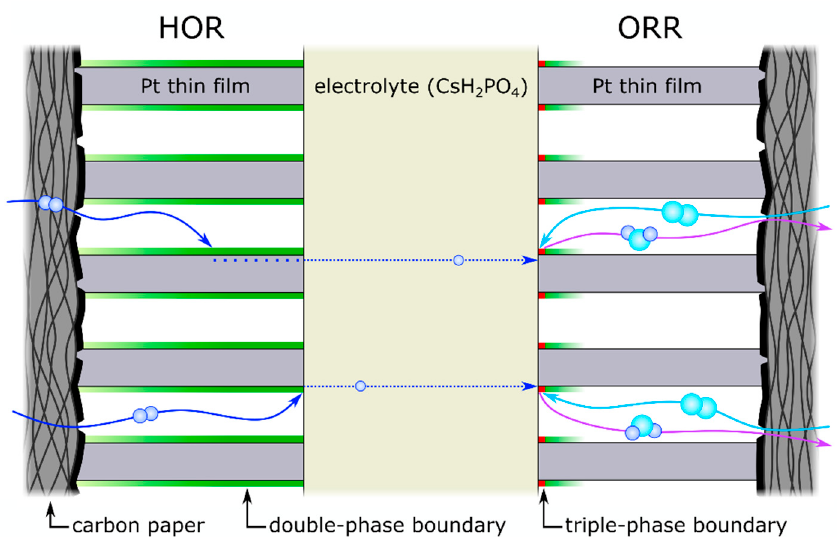
Figure 9. Cross-section through the membrane electrolyte assembly (MEA) with an illustration of the reaction pathways of the hydrogen oxidation reaction (HOR) on the left side and the oxygen reduction reaction (ORR) on the right side. The gases hydrogen (dark blue) and oxygen (light blue) as well as the reaction product, water, are marked. The green marked areas indicate the active double-phase boundary (for HOR—within 60 nm layer thickness with equal and above 60 nm gradual contribution; ORR—with a gradual contribution within 15 nm layer thickness) and the red dots the contribution of the triple-phase boundary on the ORR side. The scheme is not to